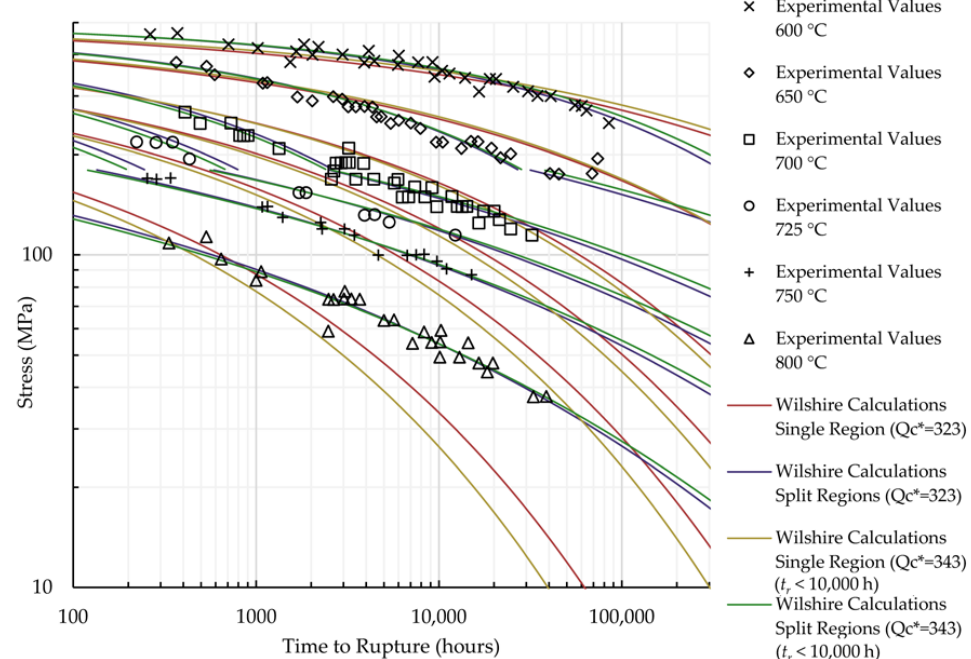
Figure A12. Calculations of the Wilshire equation for Sanicro 25 with Q ∗ the correlation of data on a Wilshire plot.